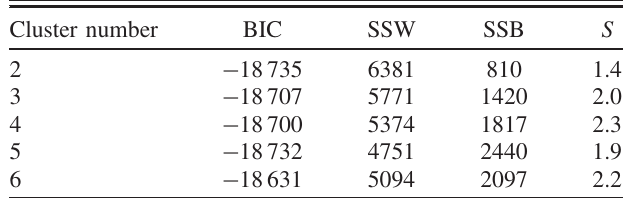
TABLE II. Measures of fit for several cluster solutions in the VVE